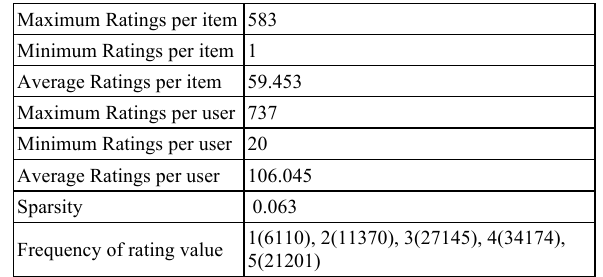
TABLE IV. S TATISTICS OF MOVIE LENS 100 K DATA SET